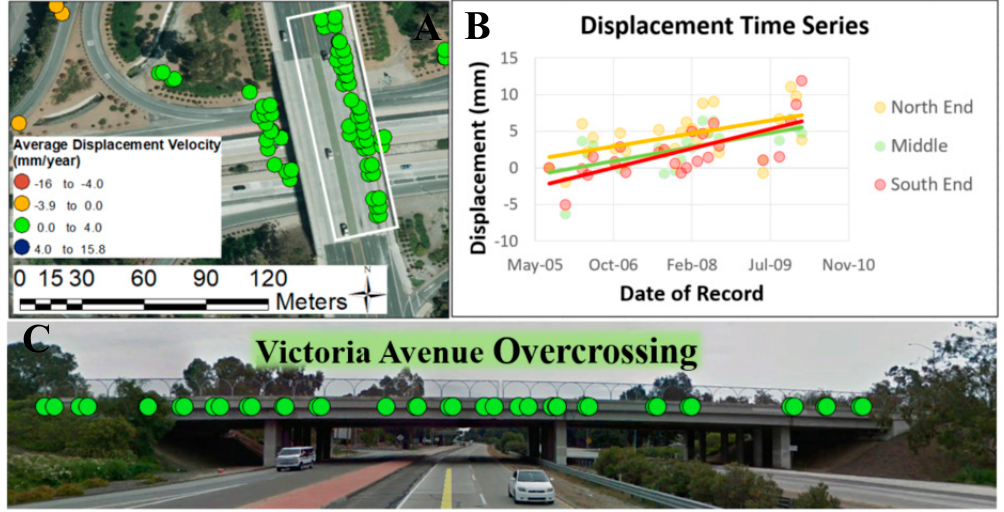
Figure 8. Victoria Avenue overcrossing displacement model. ( A ) Aerial view of the bridge; ( B ) Displacement time series; ( C ) Elevation view of the bridge. Source: Images for Figure 8A,C were obtained from Google Earth [48].